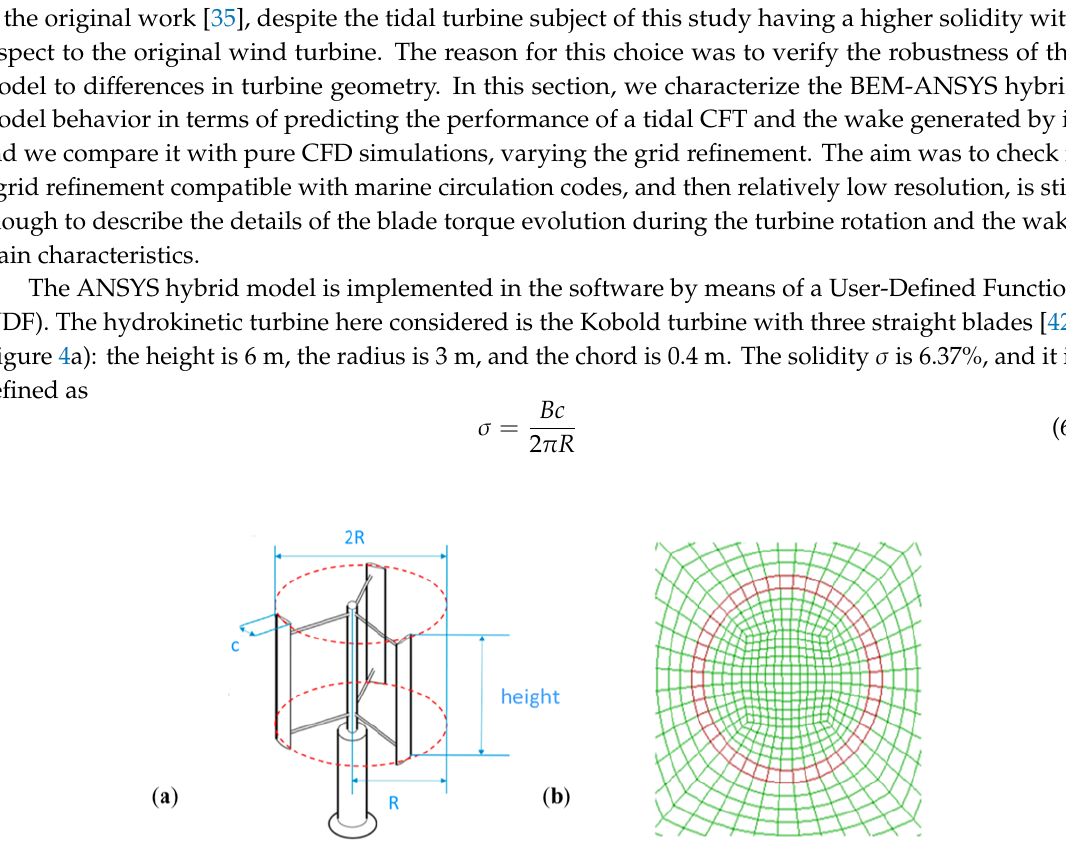
Figure 4. ( a ) Sketch of the Kobold turbine; ( b ) detail of the ANSYS grid with 44 elements on the ring.